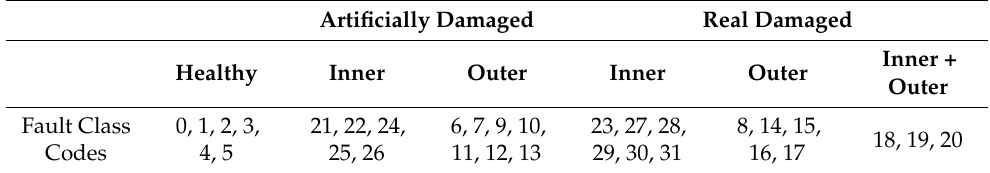
Table 2. The PU dataset fault class codes (0–31) and their corresponding fault class type.